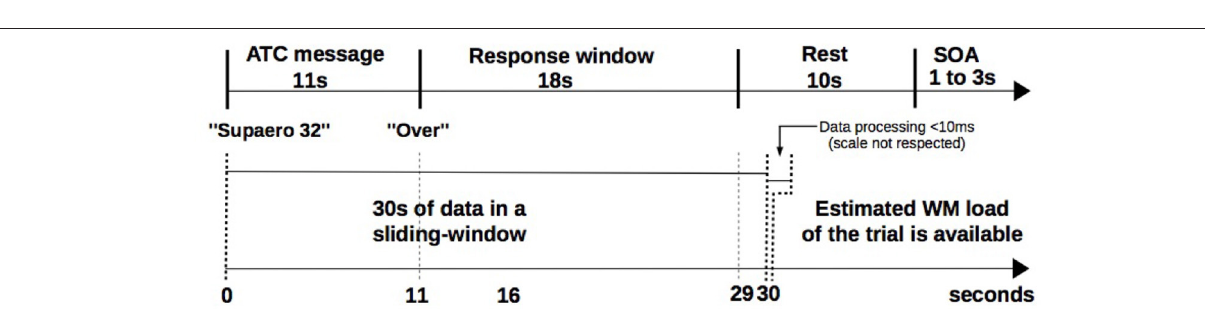
FIGURE 6 | Trial timeline and computing latencies. Upper timeline shows ATC span task trial events duration (see Figure 3 ). Bottom timeline illustrates duration constraints to get pilot’s estimated WM load: classifier’s response is available in the worst case less than 10 ms after pilot’s response